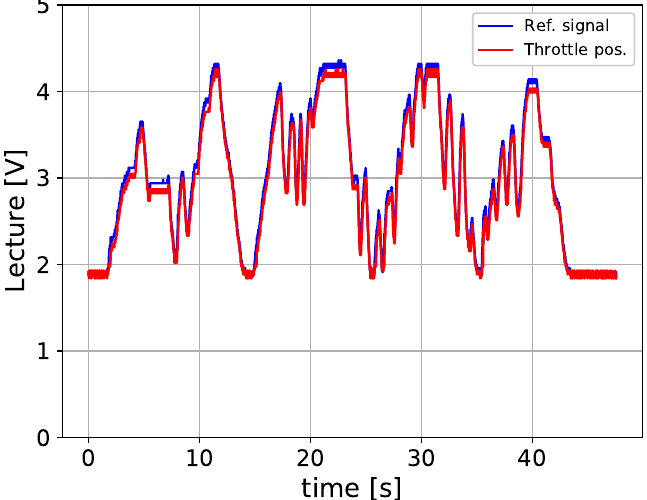
Figure 7. The throttle valve position follows the reference signal induced by the pedal emulator potentiometer.